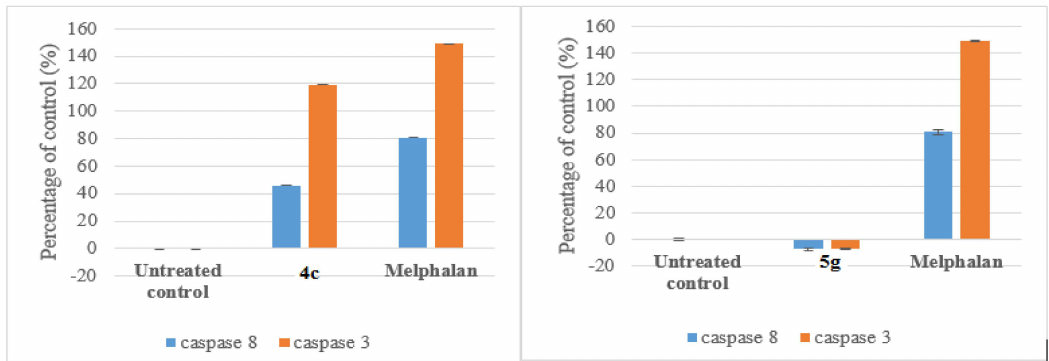
Figure 2. Caspase 8 and 3 activation as indicated by % changes in the mean integrated fluorescence intensity of the untreated control using HeLa cells after 24 h of exposure to compounds 4c and 5g (IC 50 values) using Melphalan as a positive control. Bar graph represents the average of one individual experiment performed in quadruplicate. The standard deviations are represented as error bars.